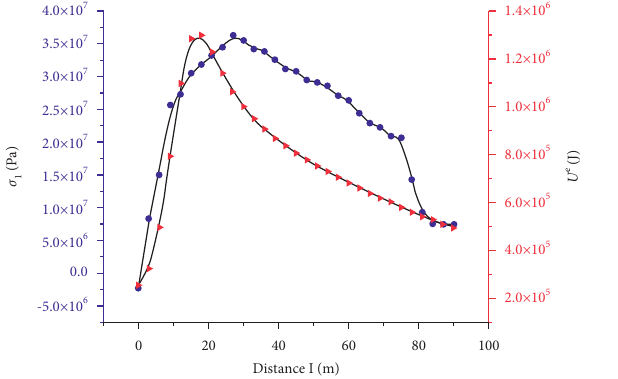
Figure 14: Relationship between σ 1 , cut by hydraulic fracturing surface